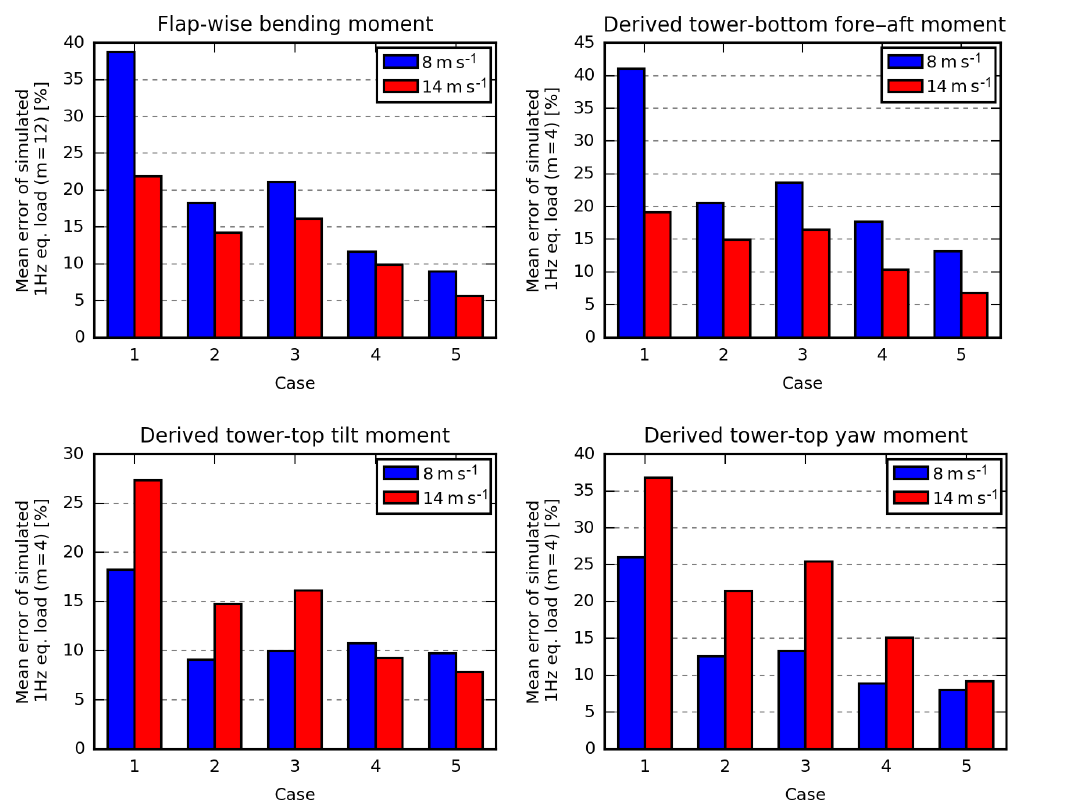
Figure 11. Mean relative error of the simulated equivalent